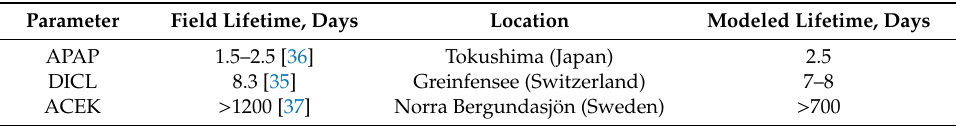
Table 2. Comparison between field data and model predictions for the phototransformation kinetics of